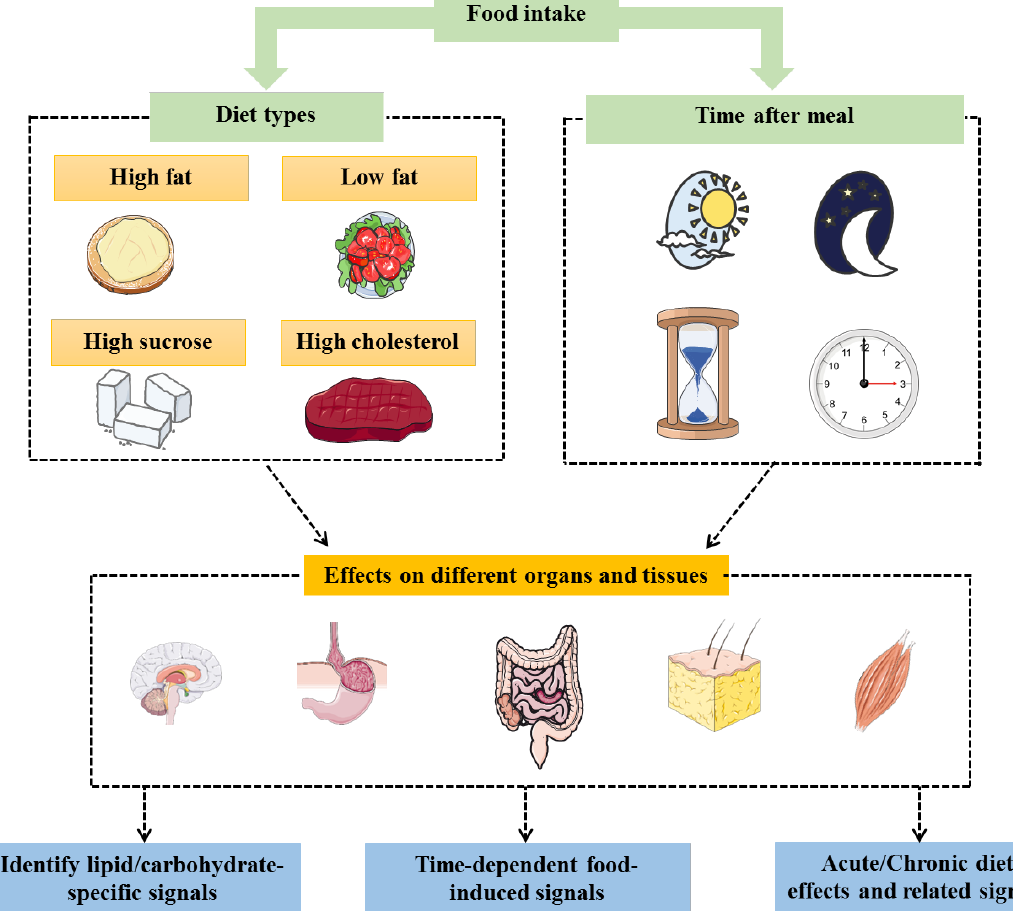
Figure 2. Studying the effects (expressed genes and the associated pathways) of different types of diets on the different organs/tissues involved in energy balance at different times allow to identify time-dependent specific signals (such as lipid-specific signals) regulating metabolism homeostasis.